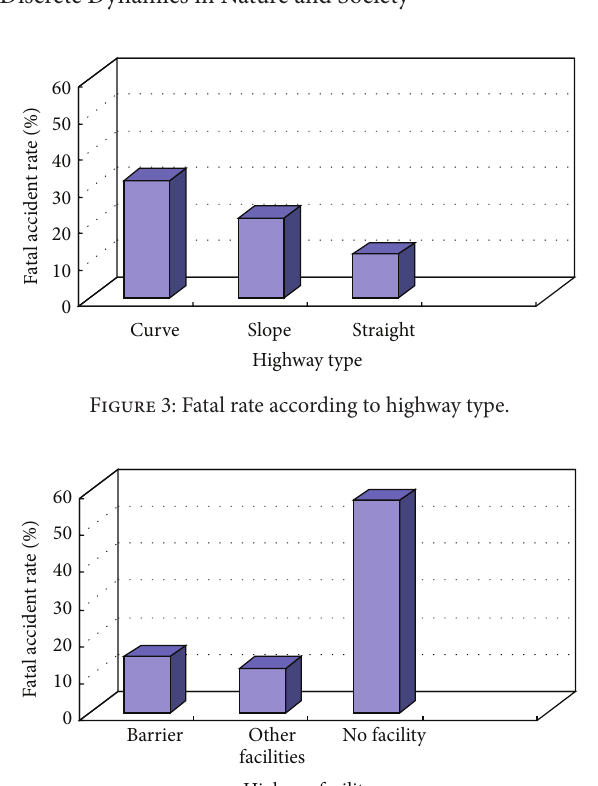
Figure 4: Fatal rate according to highway traffic facility.